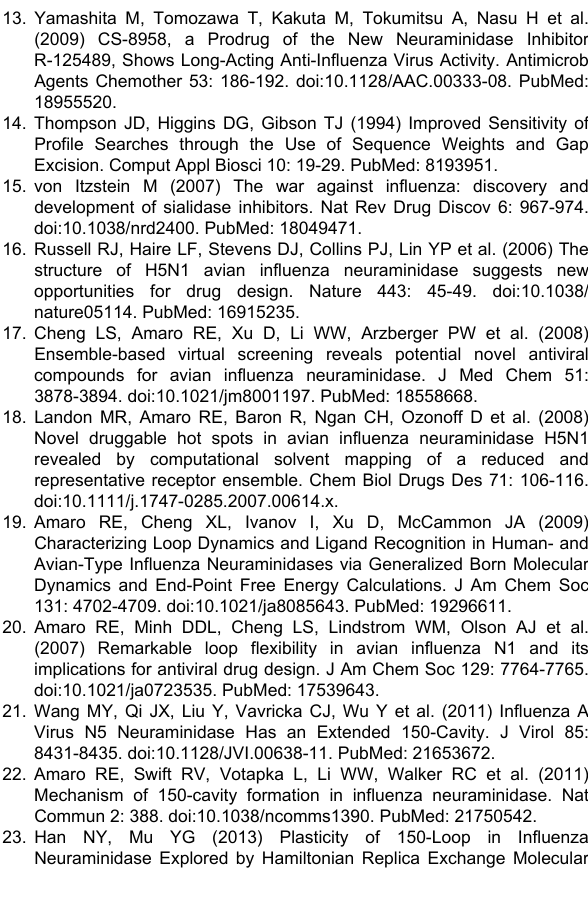
Figure S5. Pair-wise force between ZMR and the active site in all protomers of the simulation trajectories.